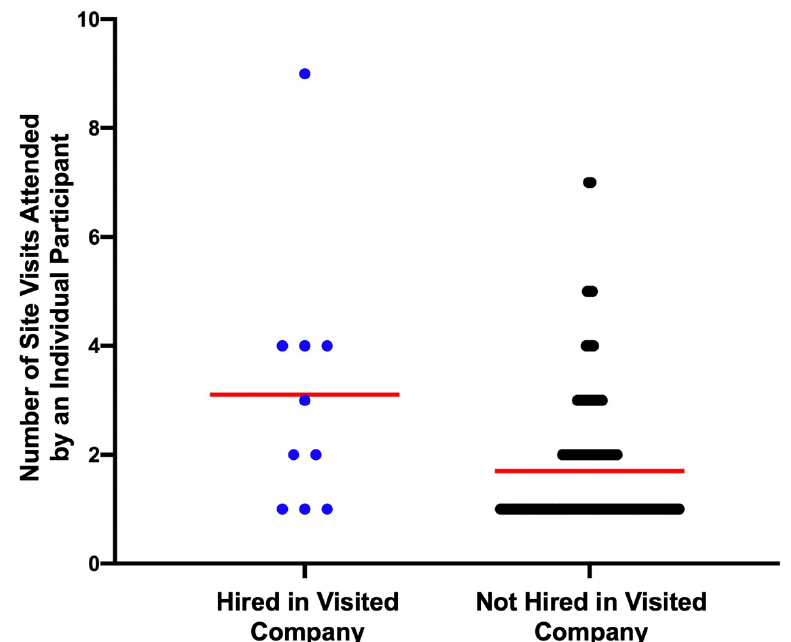
Figure 7. Individuals attending more site visits are more likely to be hired by an ELITE company visited. The ten individuals hired directly by the ELITE companies they visited attended more site visits overall on average. Those not hired into a visited company attended less visits on average (mean indicated by red